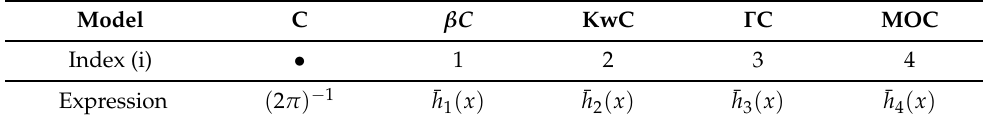
Table 1. The weighted multipliers for the proposed models.